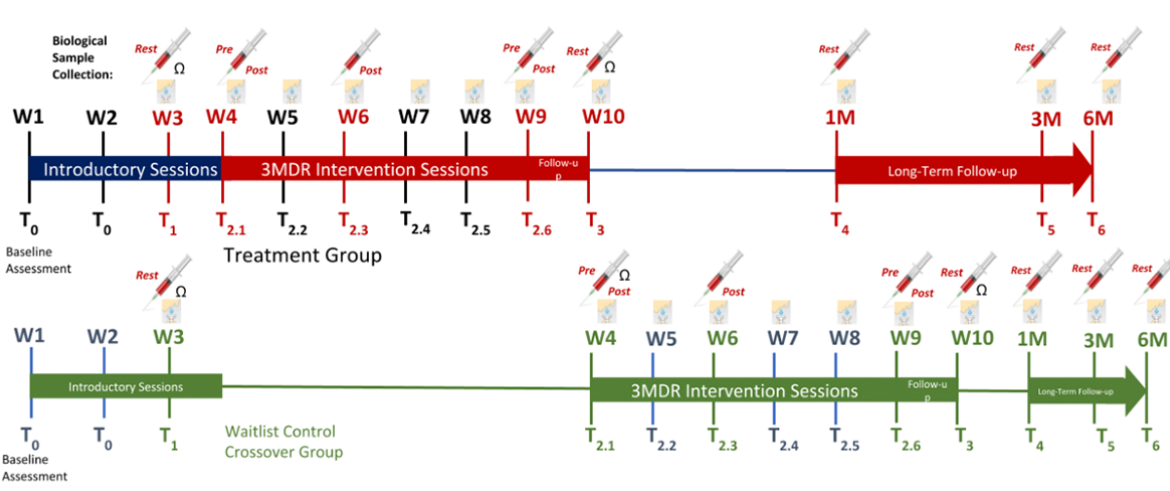
Figure 3. Multimodular motion-assisted memory desensitization and reconsolidation (3MDR) data collection time points for the intervention (treatment; blue/red) and waitlist control (green) groups. The syringe icon denotes blood collection and the square icon denotes saliva